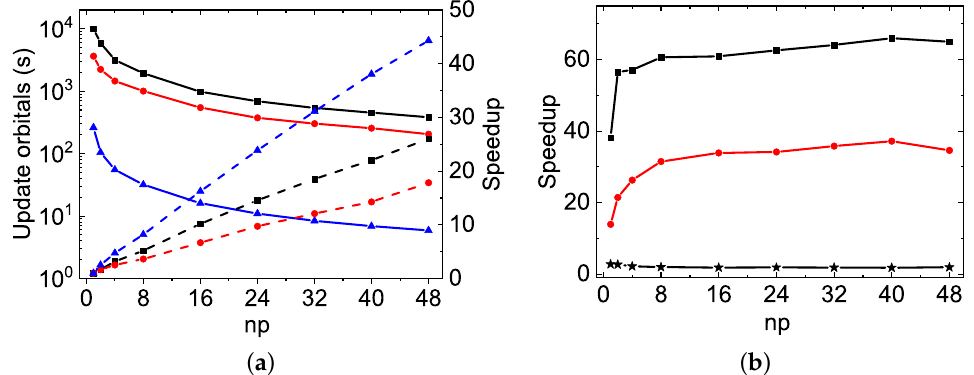
Figure 2. MPI performances for updating orbitals in the Mg VII AS 3 -SCF calculations. ( a ) Solid lines (left y axis): orbital updating CPU times ( T in s) of rmcdhf_mpi (squares), rmcdhf_mem_mpi (circles), and rmcdhf_mpi_FD (triangles) codes versus the number of MPI processes ( np ) (also listed in the second “Update” line for each code of Table 2). Dashed lines (right y axis): speed-up factors for the three codes, with the same corresponding symbols, estimated from the ratios of T ( np = 1 ) to others. ( b ) Speed-up factors of rmcdhf_mpi_FD relative to rmcdhf_mpi (squares) and to rmcdhf_mem_mpi